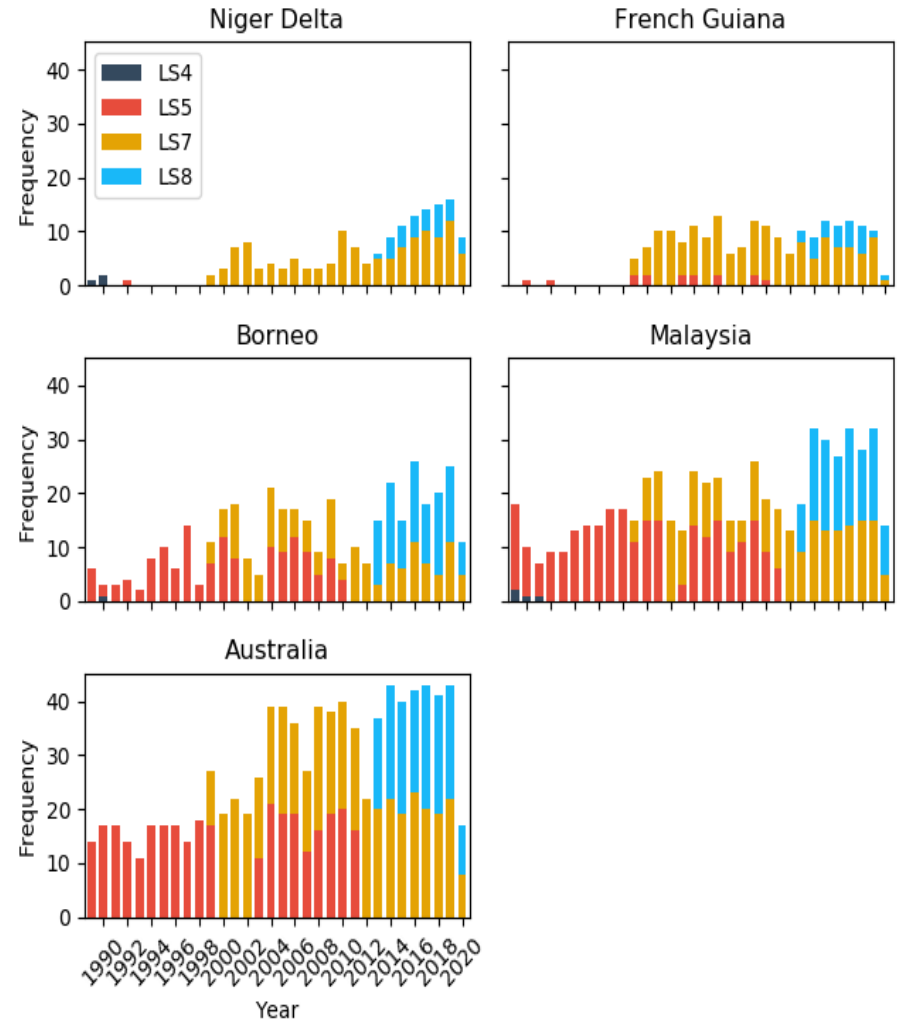
Figure 3. Plots showing the number of scenes downloaded from each satellite for each of the 30 years. There is a clear lack of imagery for the 1990’s for the Niger Delta and French Guiana sites, and a heavy reliance on Landsat 7 imagery. Data quantity for 2020 is lower because data were only processed up to mid-2020. LS4 = Landsat 4, LS5 = Landsat 5, LS7 = Landsat 7, and LS8 = Landsat